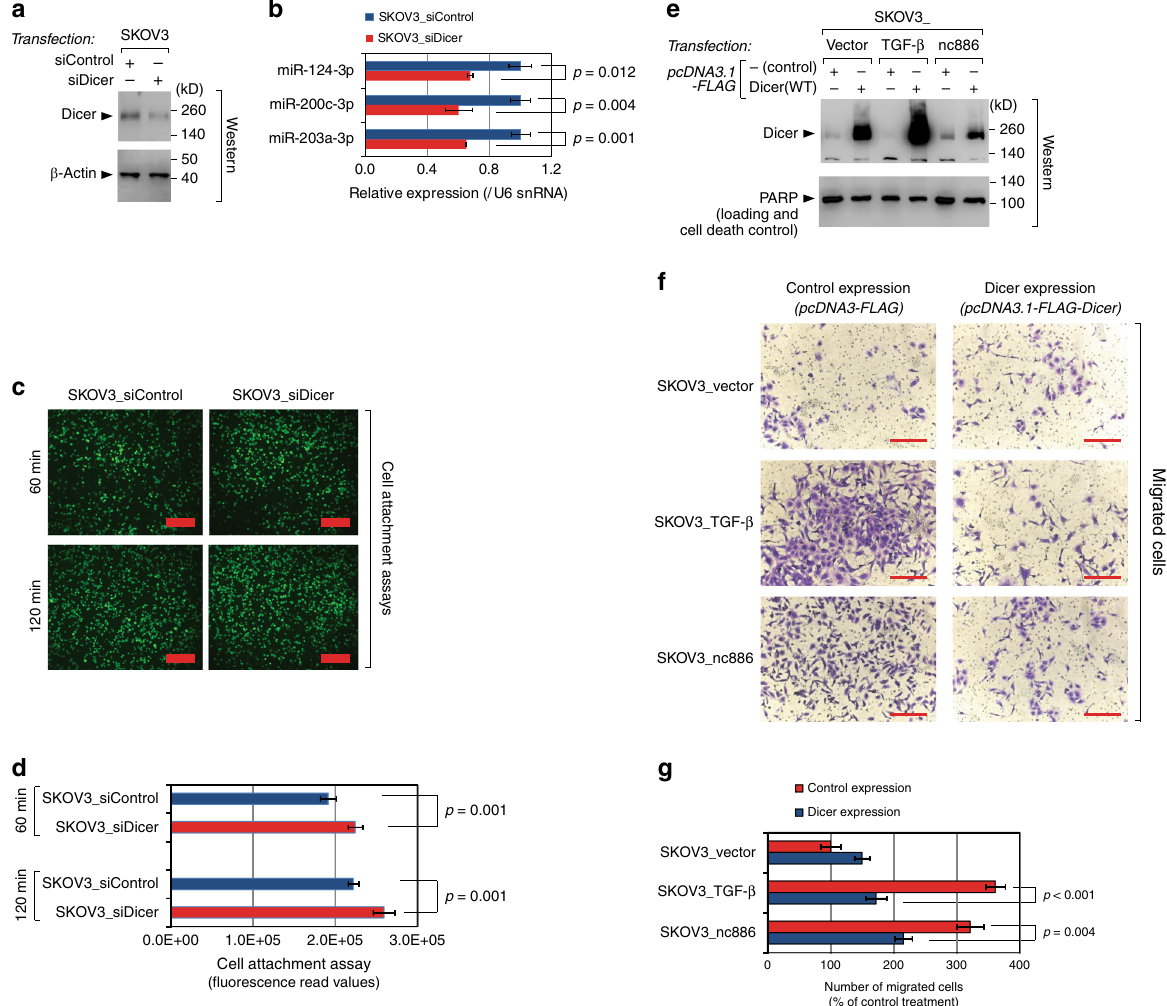
Fig. 6 The function of nc886 in tumor phenotypes is attributed to its inhibition of Dicer. a – d Cell attachment assays upon Dicer kd for 24 h. Western blot ( a ), miRNA qRT-PCR ( b ), representative images ( c ), and quanti fi cation graphs ( d ) are shown. Red thick bars indicate 1 mm ( c ). e – g Cell migration assays upon ectopic expression of Dicer. The SKOV3_vector cells were treated with TGF- β for 96 h, transfected with pcDNA3.1-FLAG-Dicer (WT) for 24 h, and then assayed. Western blot with anti-FLAG antibody ( e ), representative images ( f ), and quanti fi cation graphs ( g ) are shown. Red thin bars indicate 100 μ